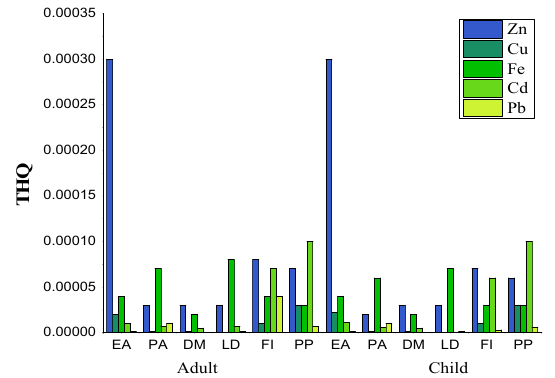
Fig. 2: Target hazardous quotient of heavy metals in fish and shellfish by adult and children (EA: Euthynnus affinis ; PA: Pampus argenteus ; DM: Descapterus macrosoma; LD: Leiognathus daura; FI: Fenneropenaeus indicus; PP: Portunus pelagicus)